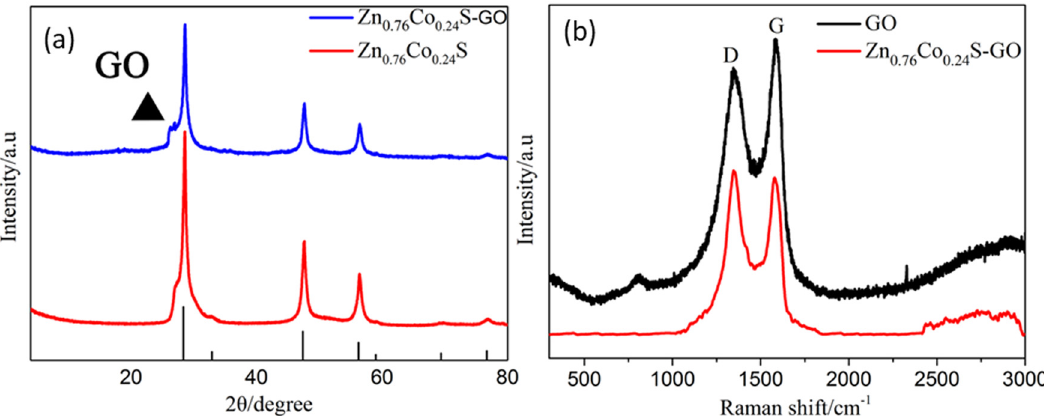
Figure 2: ( a ) XRD patterns of the Zn 0.76 Co 0.24 S@N/S - rGO and ( b ) Raman spectra of GO and Zn 0.76 Co 0.24 S@N/S -